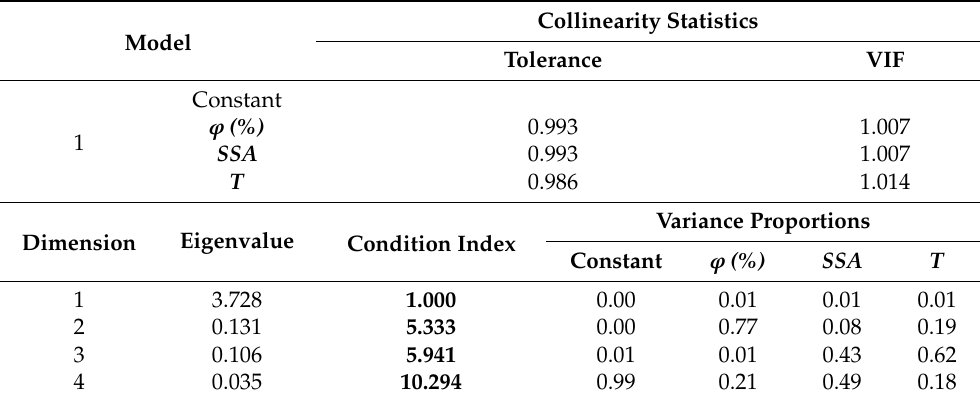
Collinearity Statistics